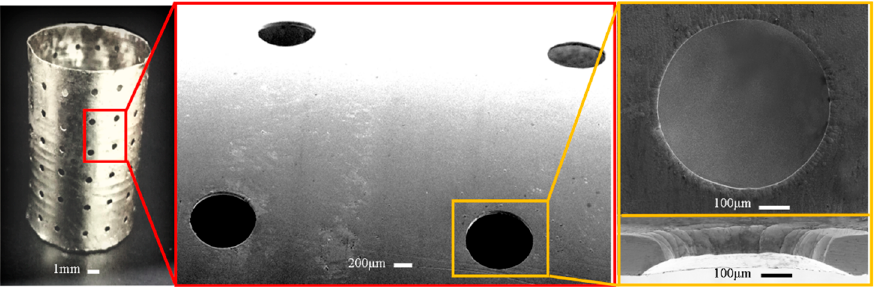
Figure 7. Electroformed seamless hollow cylinder with perforations with double conic-tapered orifices.